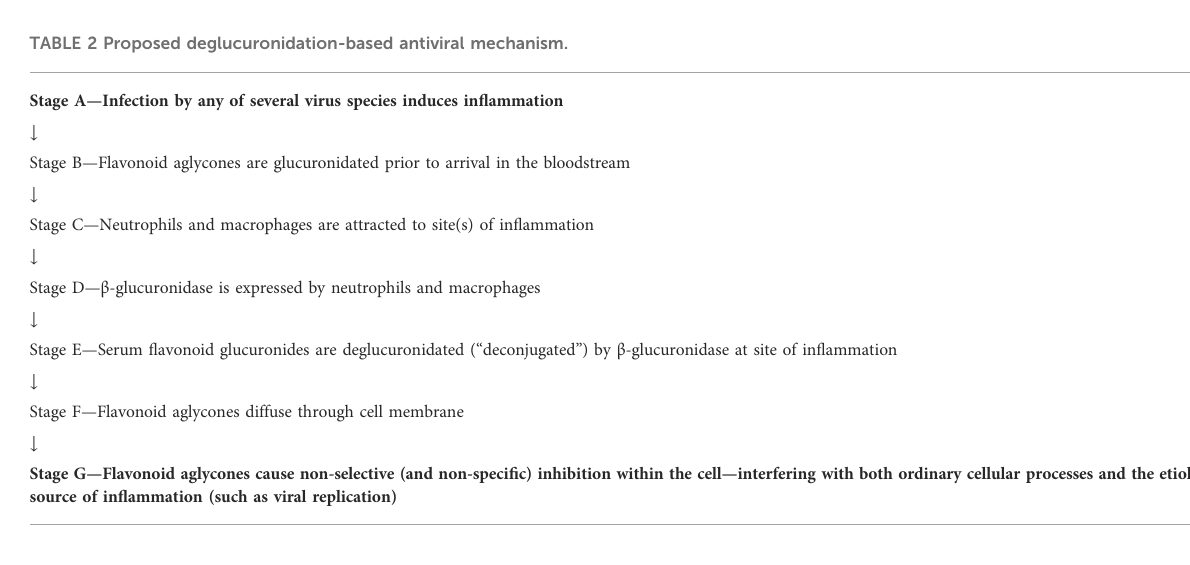
TABLE 3 in vitro evidence of in-cell viral inhibition (reported IC50) by phenols and polyphenols. DENV FMDV In fl